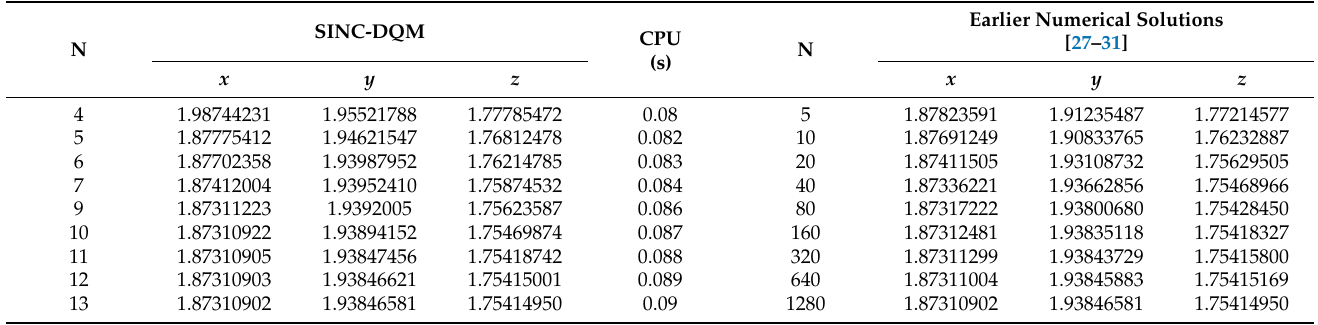
= 35, a = 3, a = 28. 2 3 1